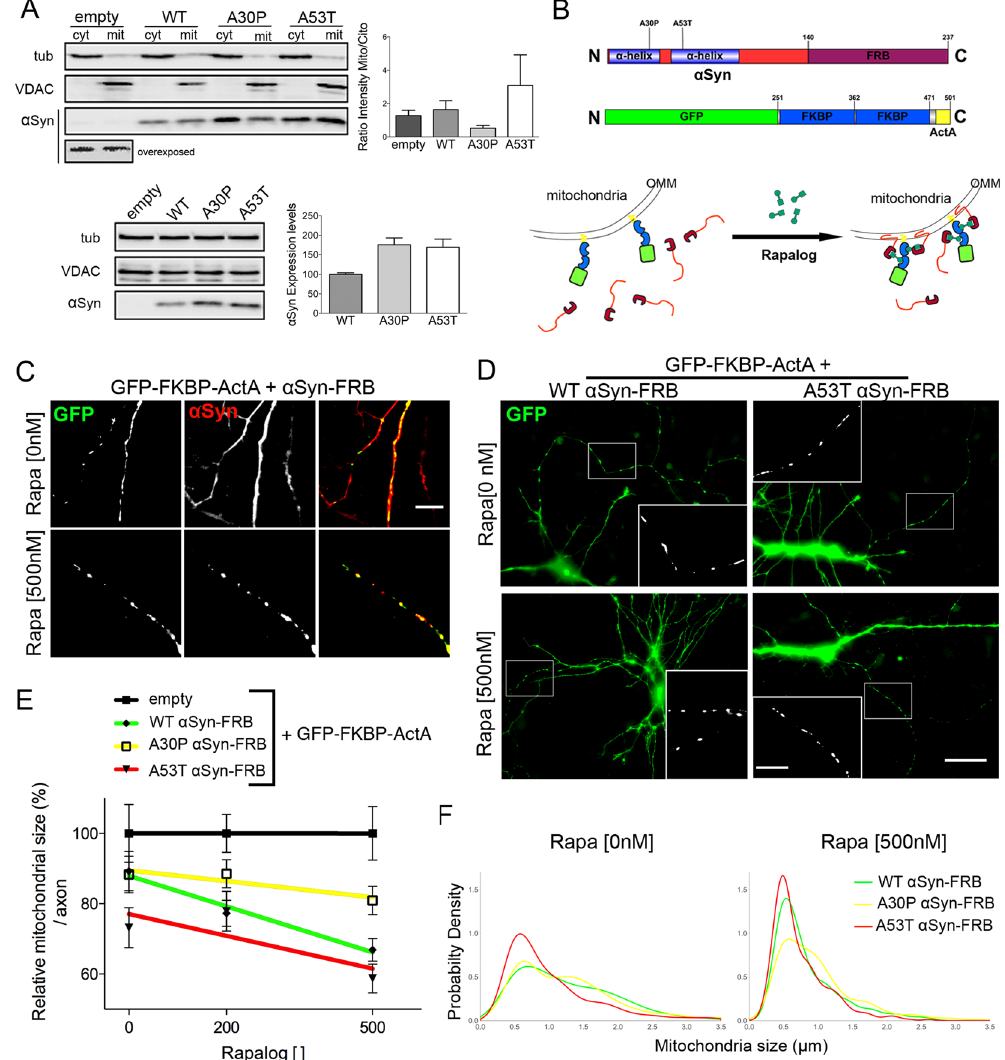
Figure 4. Differential α Syn association to mitochondrial membrane induces fragmentation. ( A ) Total, cytosolic, and mitochondrial fractions isolated by differential centrifugation of SHSY5Y cells transfected with empty, WT, A30P, or A53T α Syn vectors. Tubulin and VDAC1 were used as controls for cytosolic and mitochondrial fractions, respectively. Upper panel: α Syn enrichment quantified by mitochondrial/cytosolic ratio for control (empty), WT, A30P, or A53T α Syn normalized to the level of α Syn expression. See Figure S8 for complete overexposed gel. Lower panel: immunoblots showing total protein levels from homogenates and quantification of α Syn overexpression levels normalized to WT α Syn. Data is represented as mean ± SEM (n = 3 independent experiments). ( B ) Dimerization scheme showing fusion protein design to deliver α Syn to mitochondria. WT, A30P, or A53T α Syn were fused in-frame to FRB motif ( α Syn-FRB). A vector driving two FKBP domains fused to GFP and an OMM peptide (GFP-FKBP-ActA) that localize to mitochondria was used. FRB and FKBP dimerize in the presence of rapalog, inducing α Syn-FRB delivery to the OMM. ( C – F ) WT and A53T, but not A30P α Syn, targeting to the OMM induces mitochondrial fragmentation. ( C ) Human neurons co-transfected with GFP-FKBP-ActA and α Syn-FRB were immunostained for GFP and α Syn to observe the α Syn cytosolic localization in 0 nM rapalog and the mitochondrial delivery in the presence of 500 nM rapalog for 6 h (Scale bar, 10 μ m). ( D ) Neurons co-transfected with WT or A53T α Syn-FRB plus GFP-FKBP-ActA in the presence of 0 or 500 nM rapalog. Inset: axonal magnification. Scale bar, 30 μ m; inset, 10 μ m. ( E ) Mean mitochondrial size quantification per axon in 0, 200, or 500 nM rapalog for 6 h normalized to empty vector control. Linear regression, slopes, and deviation from zero were assessed (WT α Syn-FRB: − 0.043, p < 0.001; A30P α Syn-FRB: − 0.015, p > 0.05; A53T α Syn-FRB: − 0.031, p < 0.05). Data is presented as mean ± SEM (n = 15 axons per condition from 3 independent experiments). ( F ) Probability function distribution of total pooled mitochondrial size measured in WT, A30P, or A53T α Syn-FRB plus GFP-FKBP-ActA neurons in 0 or 500 nM rapalog. (n > 300 mitochondria from 3 independent experiments). See also Figure